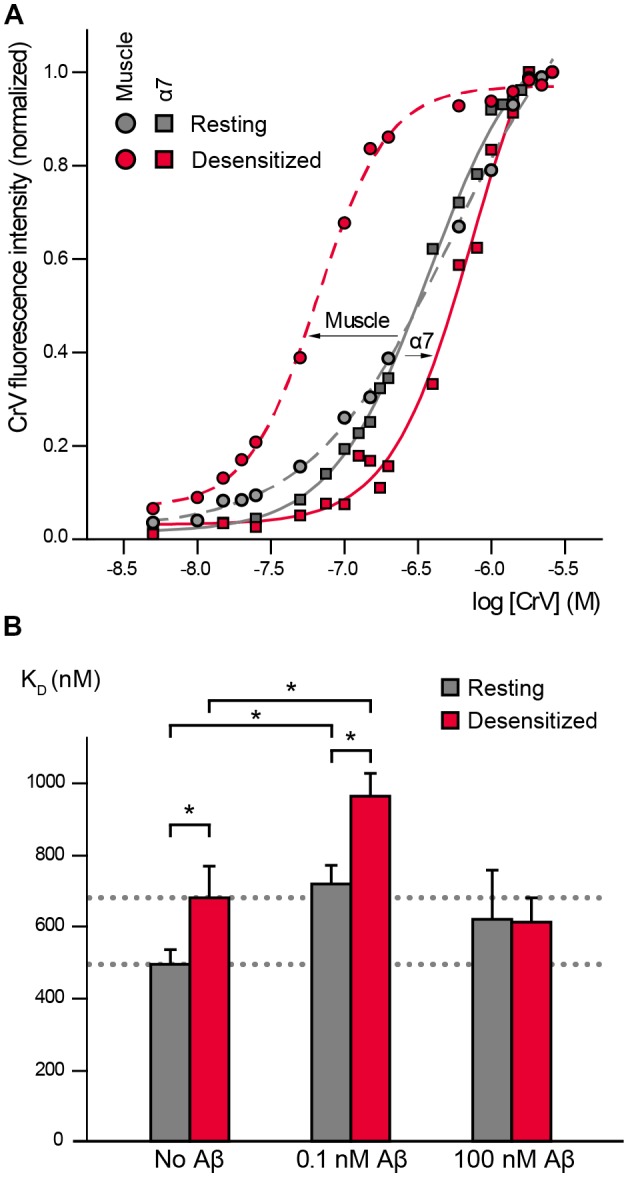
α7 conformational changes depend on Amyloid β peptide (Aβ) concentrations. (A) Crystal violet (CrV) titration curves obtained with muscle nicotinic acetylcholine receptor (nAChR) from T. californica rich membranes (circles) and with human α7 (squares) in the absence (gray, Resting) and presence of carbamylcholine (Carb; red, desensitized). The arrows indicate the changes from resting to desensitized conditions for each nAChR type. (B) Changes in KD values of CrV by the exposure to low (0.1 nM) and high (100 nM) concentrations of Aβ1–40. KD values of CrV were calculated from the titration curves, in the absence and presence of 20 mM Carb (gray and red columns, respectively). Each column corresponds to the average ± SD of more than four independent experiments. Statistically significant differences are shown by asterisks, *p < 0.05.